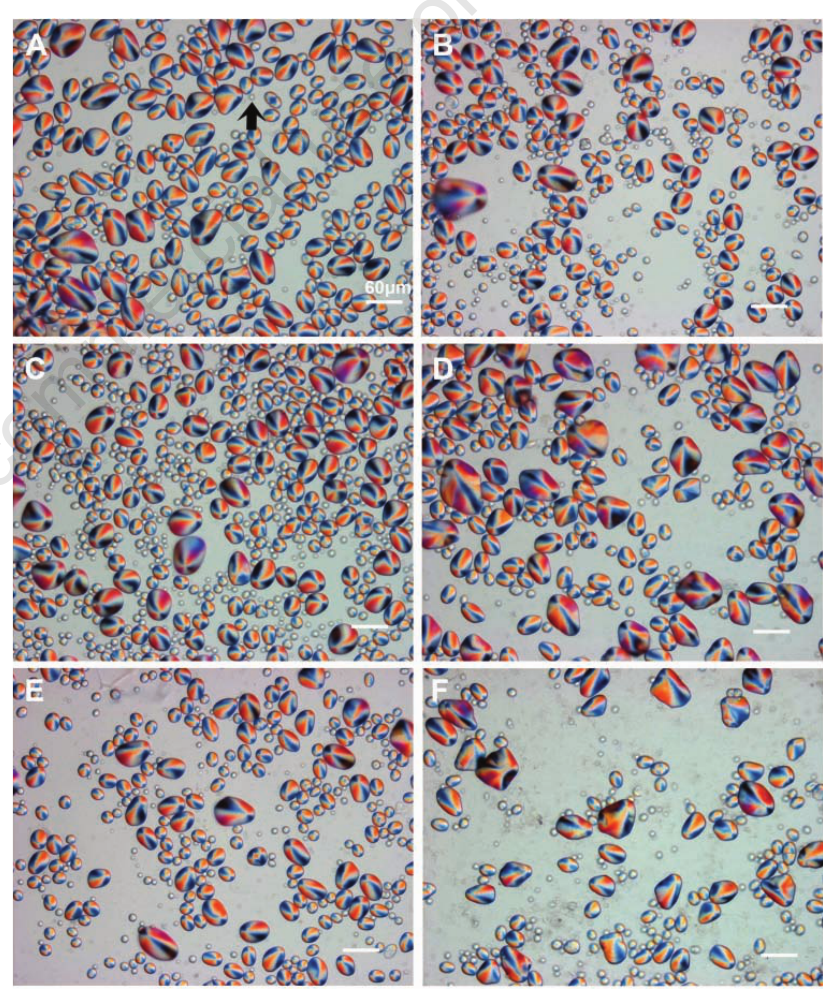
Figure 1. Starch granules of different potato cultivars. Microscopic objective: 20X. (A) AC Novachip; (B) AR2006-02 (F01004); (C) AR2006-07(F01061); (D) F03007; (E) F03049; (F) Kennebec. The small starch granule indicated by an arrow as a tiny spot in Figure 1A had a length of 8.5 µm. Starch granules larger than 8 µm were